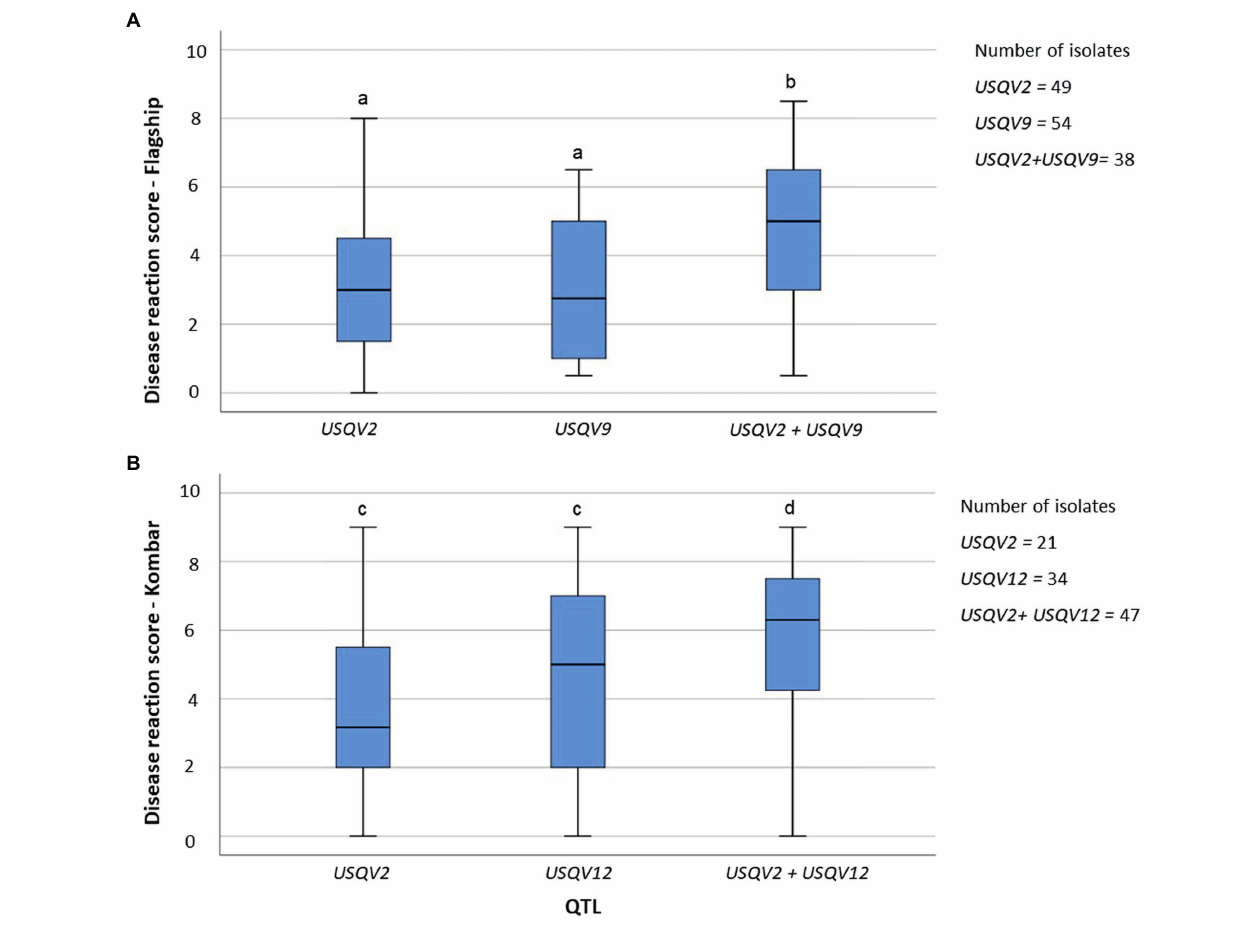
FIGURE 4 | Pyramiding of QTL associated with virulence of P. teres for Flagship (A) and Kombar (B) . Boxes with similar letters are not significantly different ( p =